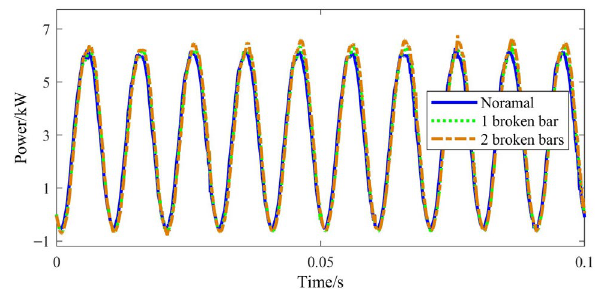
Figure 18. Input power time-domain signal.